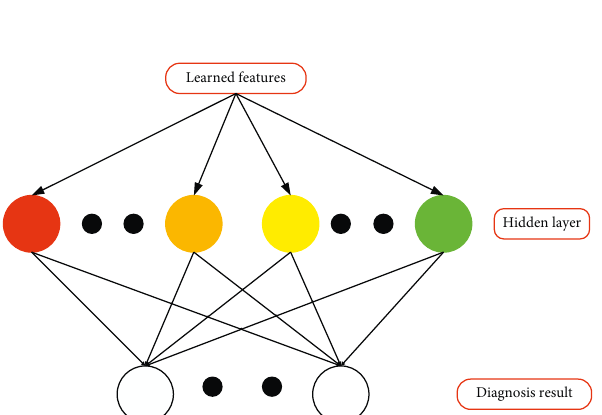
Figure 3: Structure of DGRU.